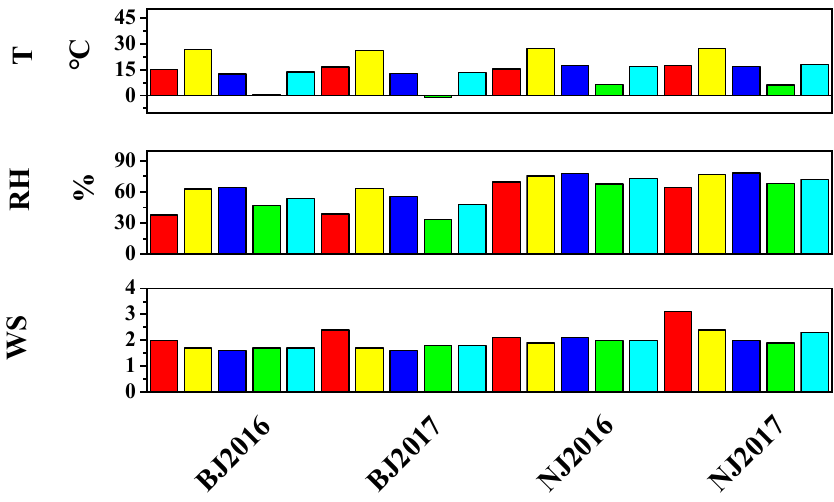
Figure 7. Seasonal and annual average measurements of ambient temperature (T, °C), relative humidity (RH, %), and surface wind scale (WS) in different cities and years. Red, yellow, dark blue, green, and light blue represent spring, summer, fall, winter, and annual values, respectively.